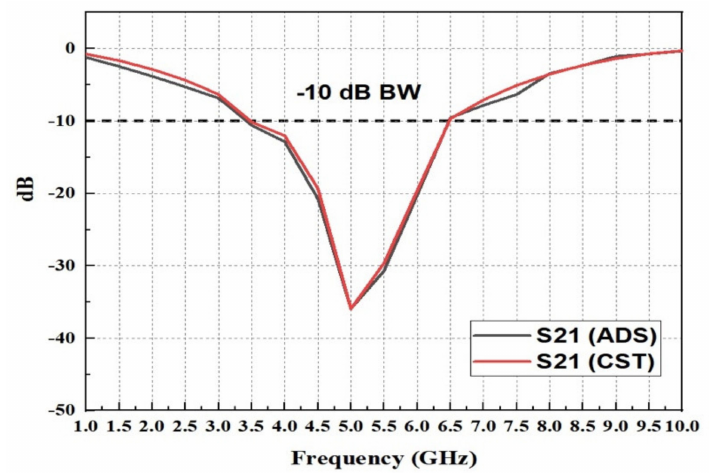
Figure 7. S21 comparison of the equivalent circuit result with